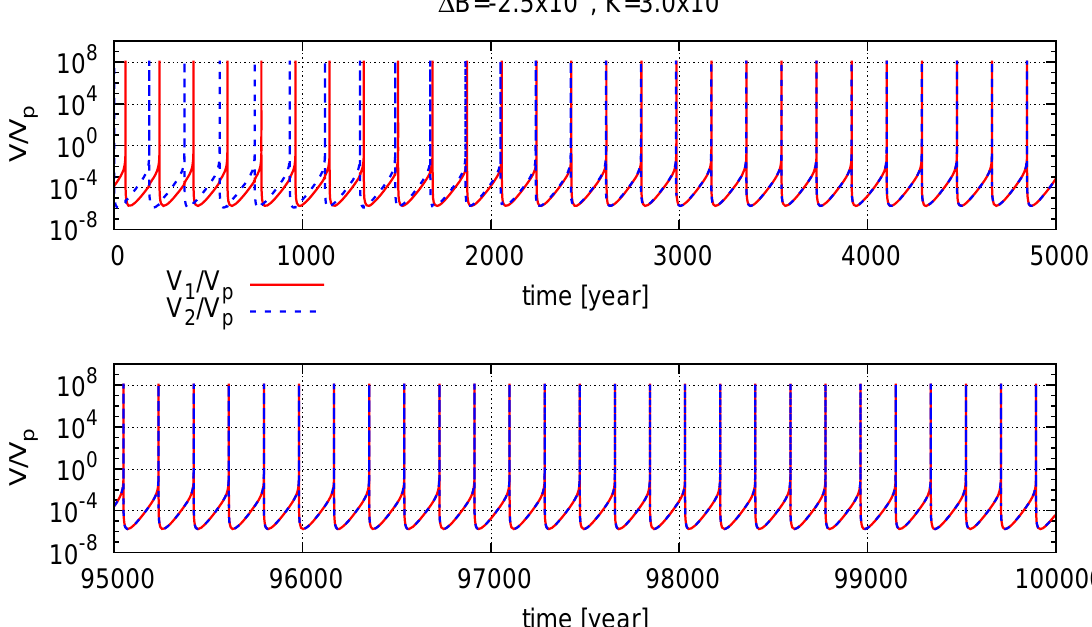
Fig. 7. The time evolution of V/V p for case 2 in a logarithmic scale. The variation from 5000 to 95000yr is not shown. The parameters are B = 2 . 20 × 10 5 Nm − 2 for oscillator 1, B = 2 . 225 × 10 5 Nm − 2 for oscillator 2, and K = 3 × 10 3 Nm − 3 . The oscillators synchronize at a phase difference of ψ = − 7 . 07 × 10 − 3 .